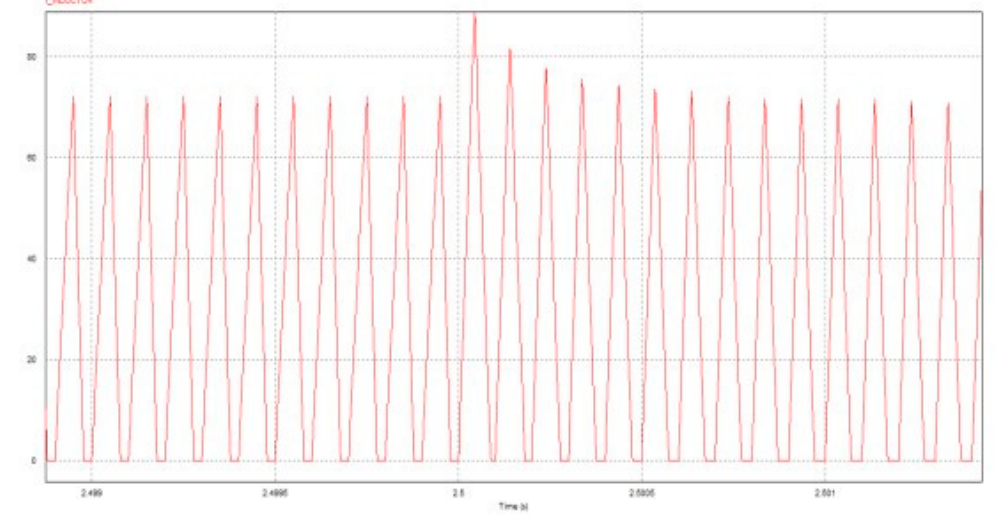
Figure 6. Transient response of the current in the inductor in the Island